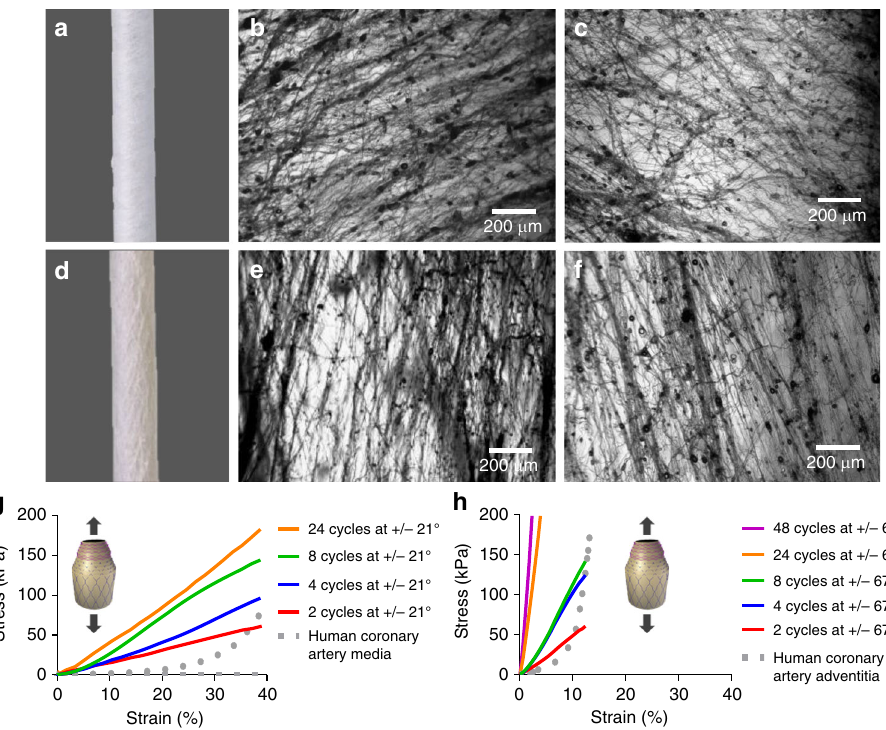
Fig. 3 Poly( ε - caprolactone) (PCL) sublayers. a Macroscopic inspection of PCL fi bres at 21° angle co-deposited in both orientations ( + / − 21°). b , c , e , f Optical microscopy of fi bres obtained after one cycle of PCL fi bre deposition using individual orientations. b , c Single cycle of PCL fi bre deposition at + / − 21° angle using a clockwise ( + 21°) and an anti-clockwise ( − 21°) rod rotation, respectively. d Mascroscopic inspection of PCL fi bres at 67° angle co- deposited in both orientations ( + / − 67°). e , f Single cycle of PCL fi bre deposition at + / − 67° angle using a clockwise ( + 67°) and anti-clockwise ( + / − 67°) rod rotation, respectively. g , h Stress – strain curves for longitudinal tensile testing conducted on PCL sublayers fabricated at deposition angles of + / − 21° and + / − 67°, respectively. PCL sublayers were manufactured using different number of cycles of intercalated PCL fi bres deposited at opposite angles ( + / − ). Every fi bre deposition cycle using a clockwise rotational direction is alternated with a second fi bre deposition cycle using an